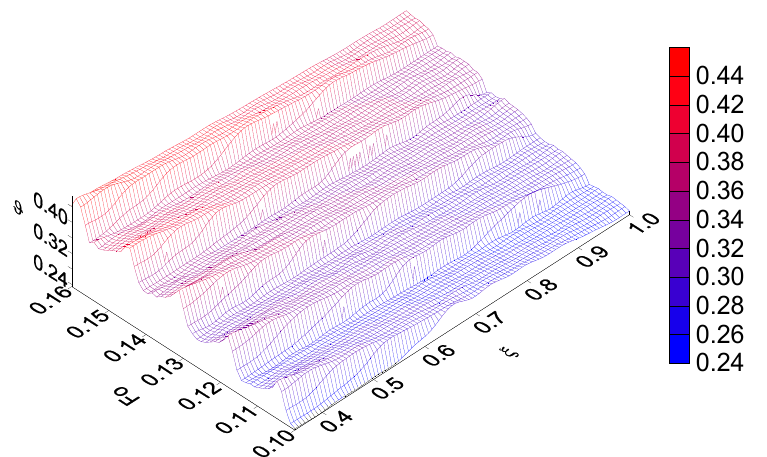
Figure 4. The temperature distribution along the ray ε 0 ≤ ξ ≤ 1, θ = 0, ζ = 0.5 for four periods of os- cillation.